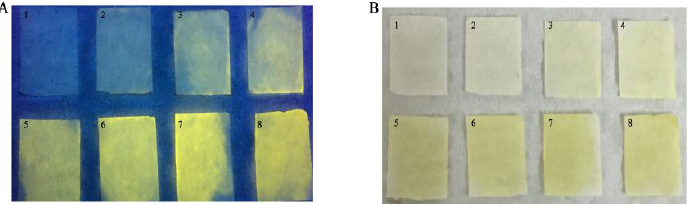
Figure 6. ( A ) Color changes of test papers impregnated with glucose oxidase (Gox), HRP, ODB and CQDs under 365 nm UV light, after immersion into solutions containing 0, 10, 50, 100, 150, 200, 300 and 500 μM glucose, respectively. ( B ) Their corresponding color changes under sunlight.